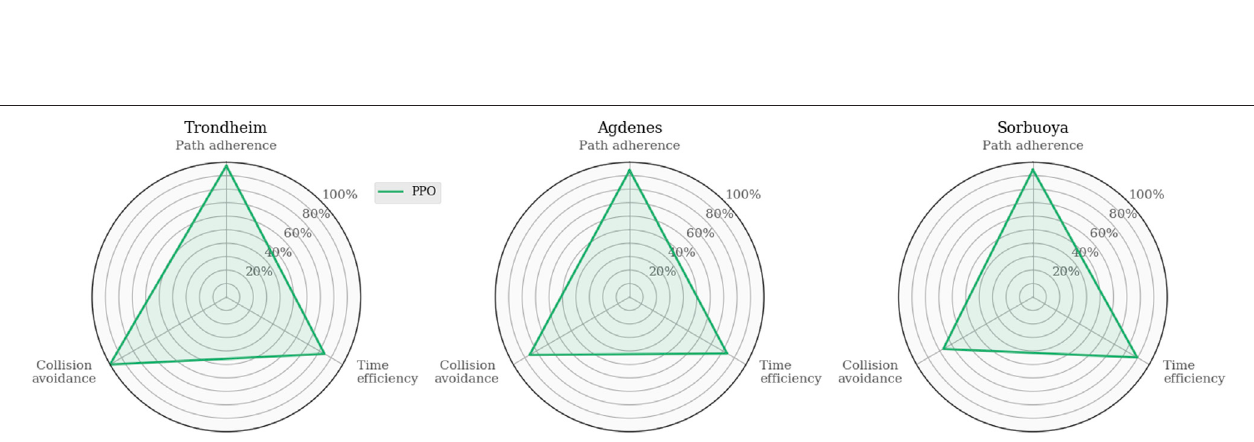
FIGURE 7 | Evaluating the PPO agent trained in MovingObstaclesNoRules by testing it in simulated real-world environments for later reference.